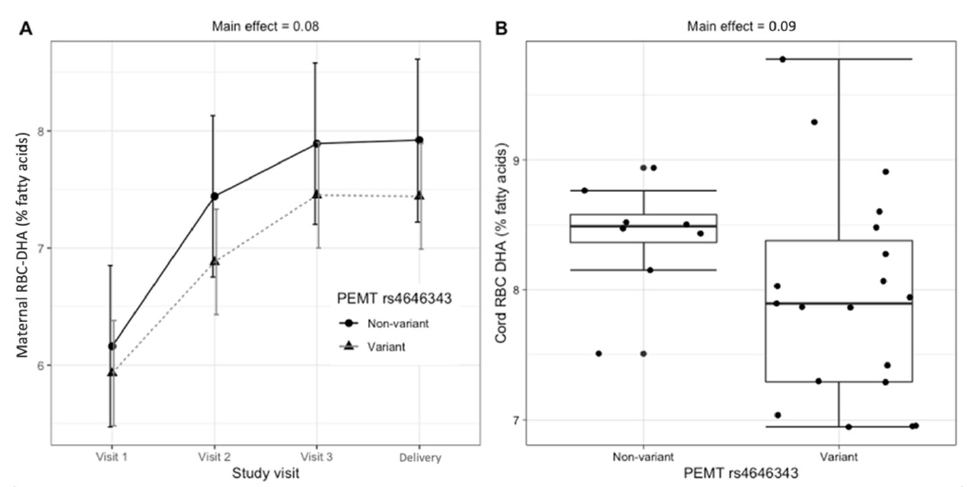
Figure 2. Relationship between maternal PEMT rs4646343 genotype and RBC-DHA (% of total fatty acids). ( A ) Maternal RBC-DHA throughout gestation (LSM ± confidence interval); ( B ) cord RBC-DHA at delivery (raw data boxplot).